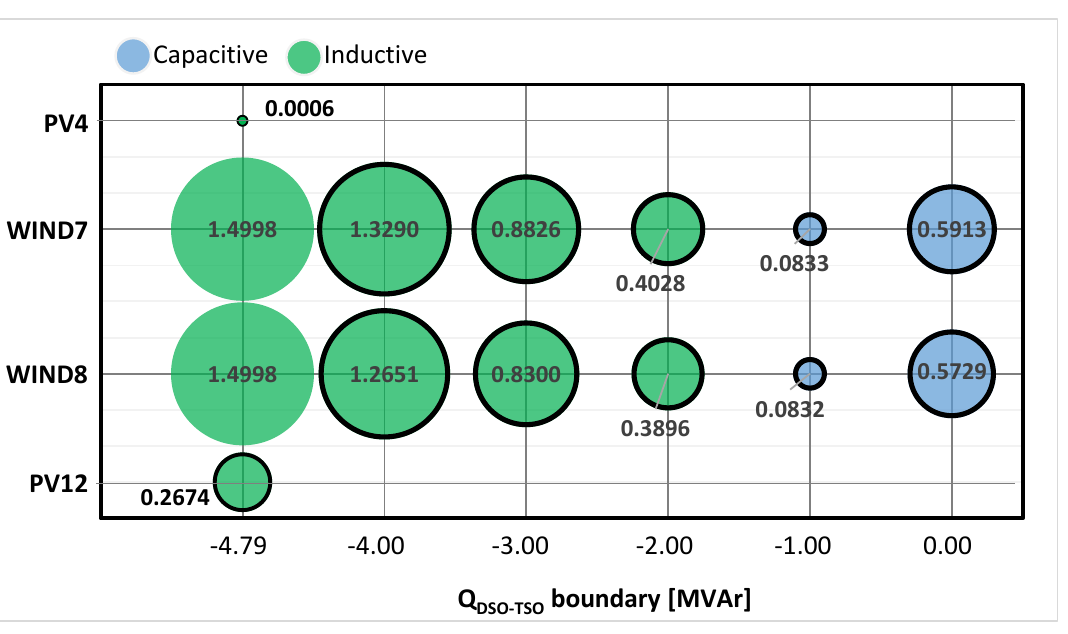
Figure 8. Reactive power scheduled for increasing TSO Q inductive needs.